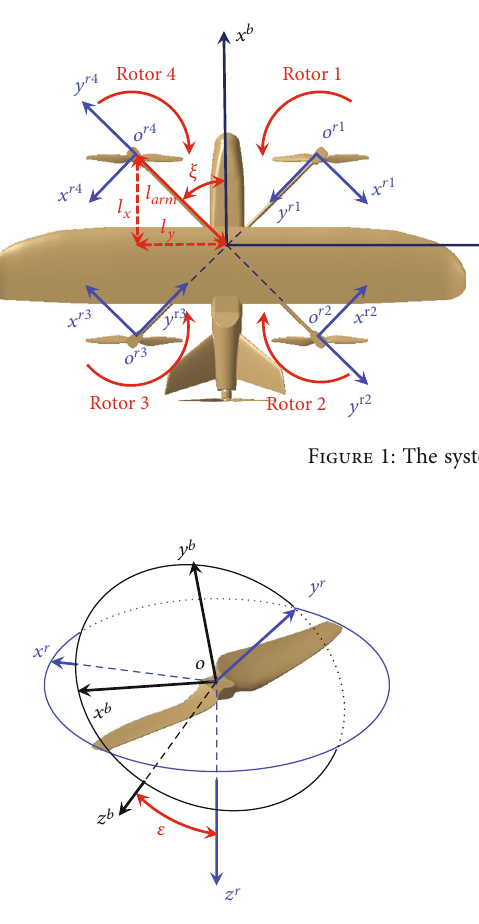
Figure 2: The de fi nition of the rotor incline angle.